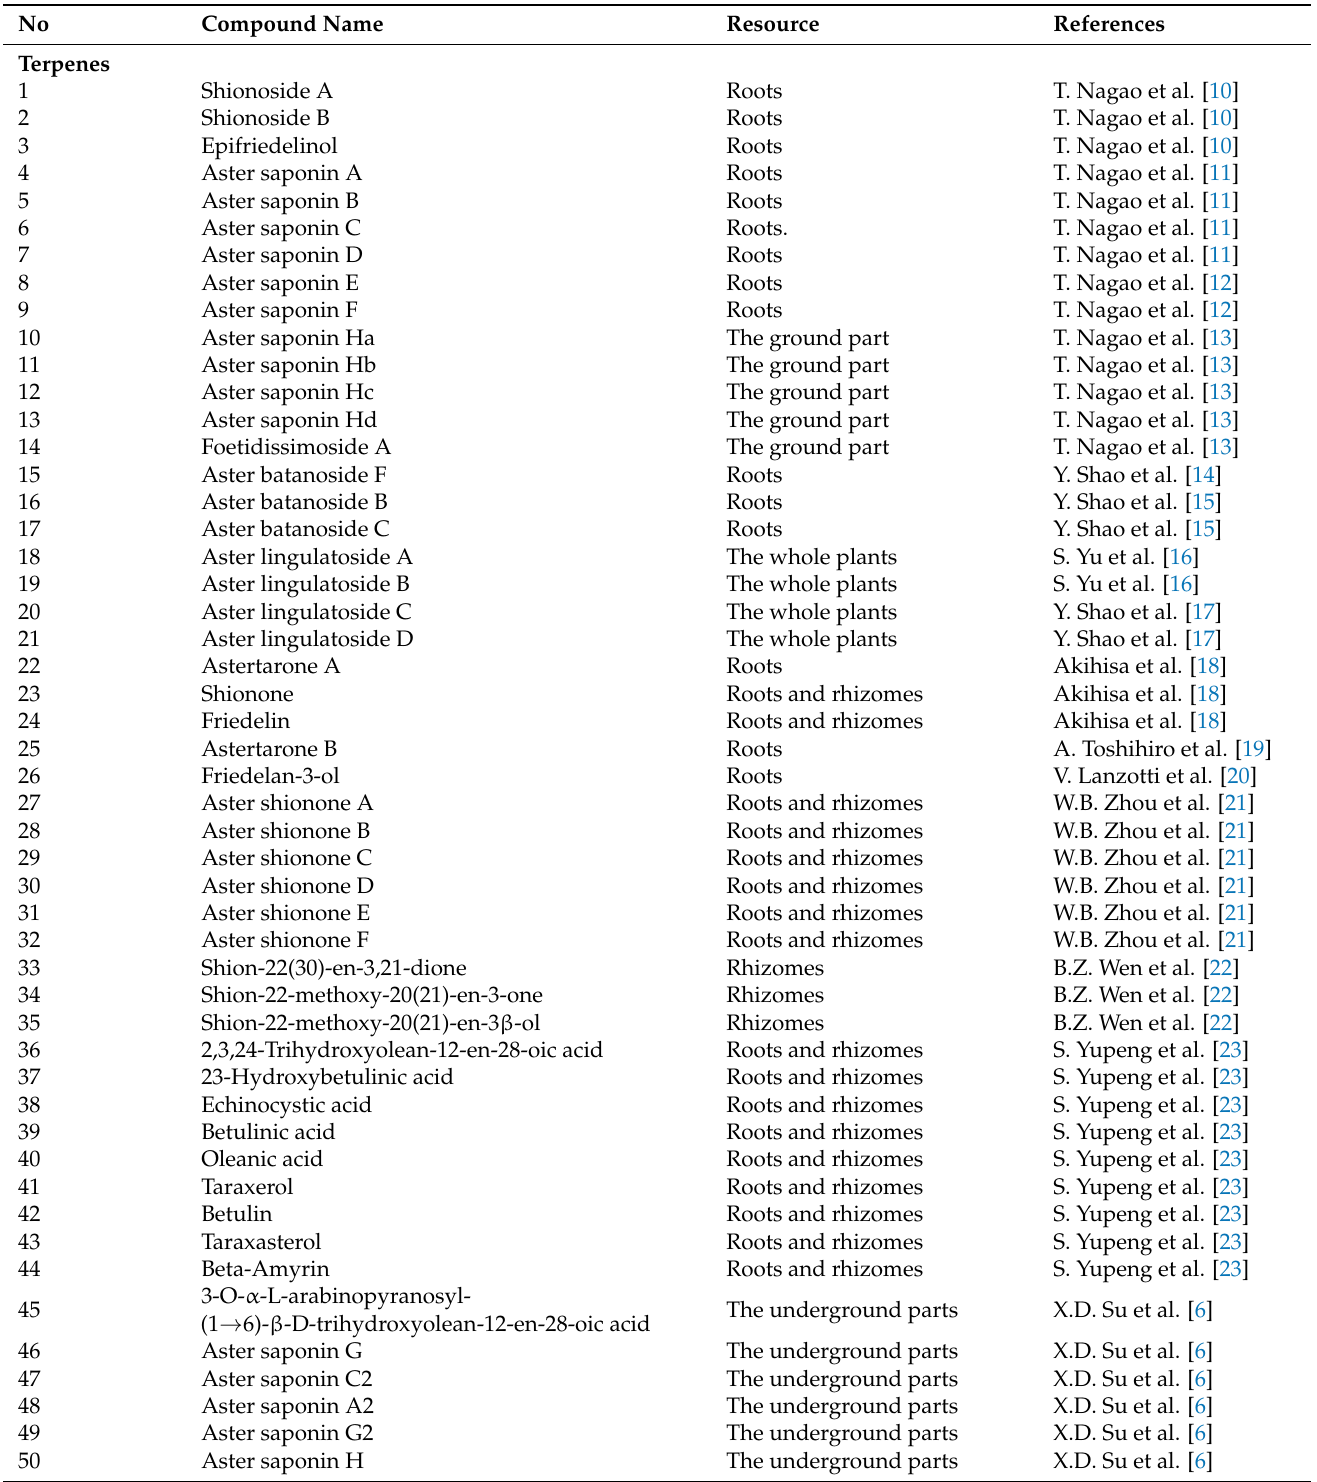
Table 3. Compounds and activities isolated from Radix